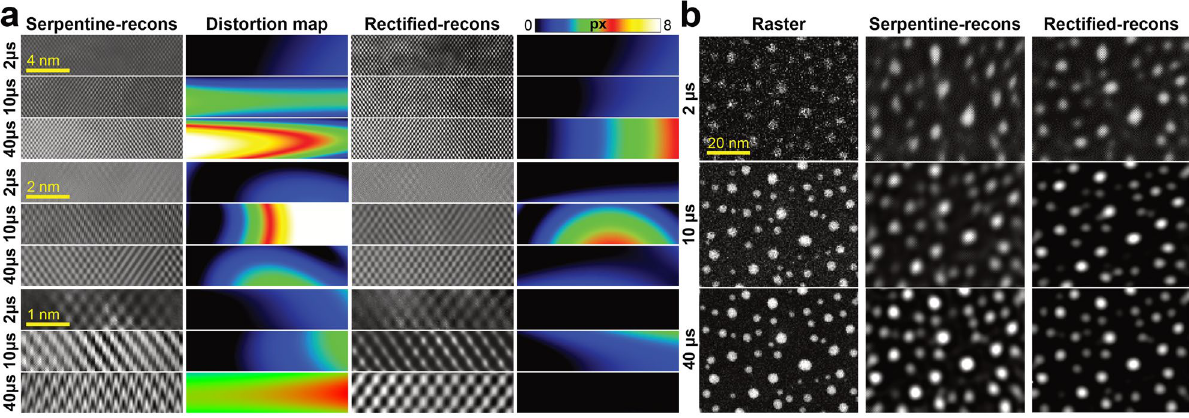
Figure 6. Comparison between rectified-reconstructed and experimental STEM images. ( a ) Difference between Serpentine-reconstructions and Rectified-reconstructions of experimental sparse(1/3)-serpentine [110] Si images at different image size and T D . The color maps quantify the degree of misalignment (in pixels) between the postprocessed atom positions and the ideal lattice. ( b ) Comparison between raster, serpentine- reconstructions, and rectified-reconstructions of the